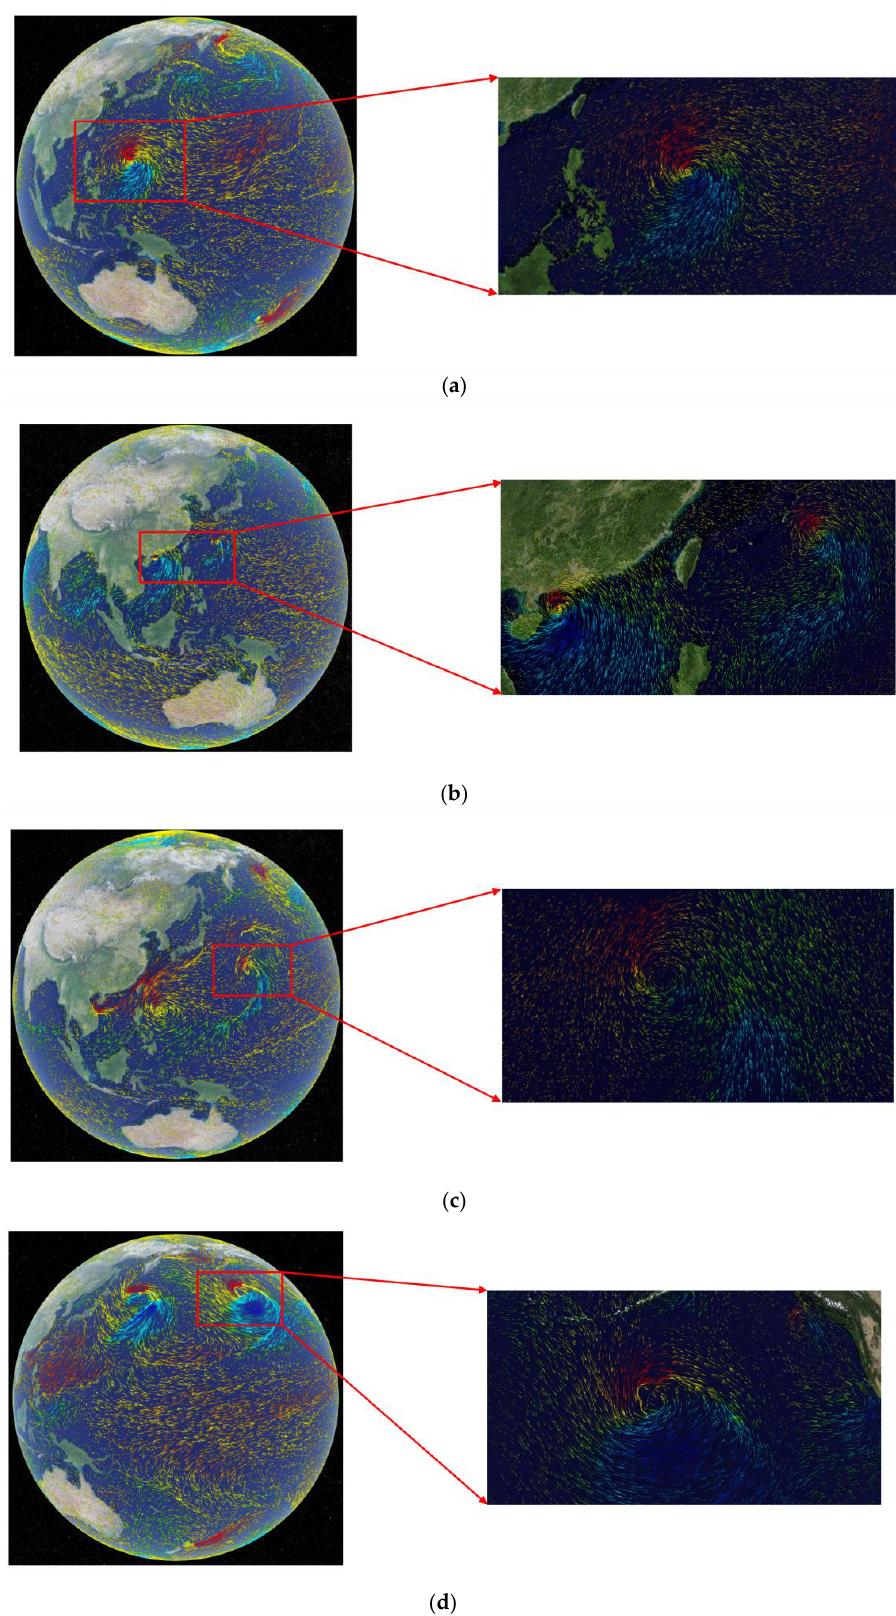
Figure 13. ( a ) Wind experiment result from 12 April 2022; ( b ) wind experiment result from 2 July 2022; ( c ) wind experiment result from 14 October 2022; ( d ) wind experiment result from 10 January 2023.